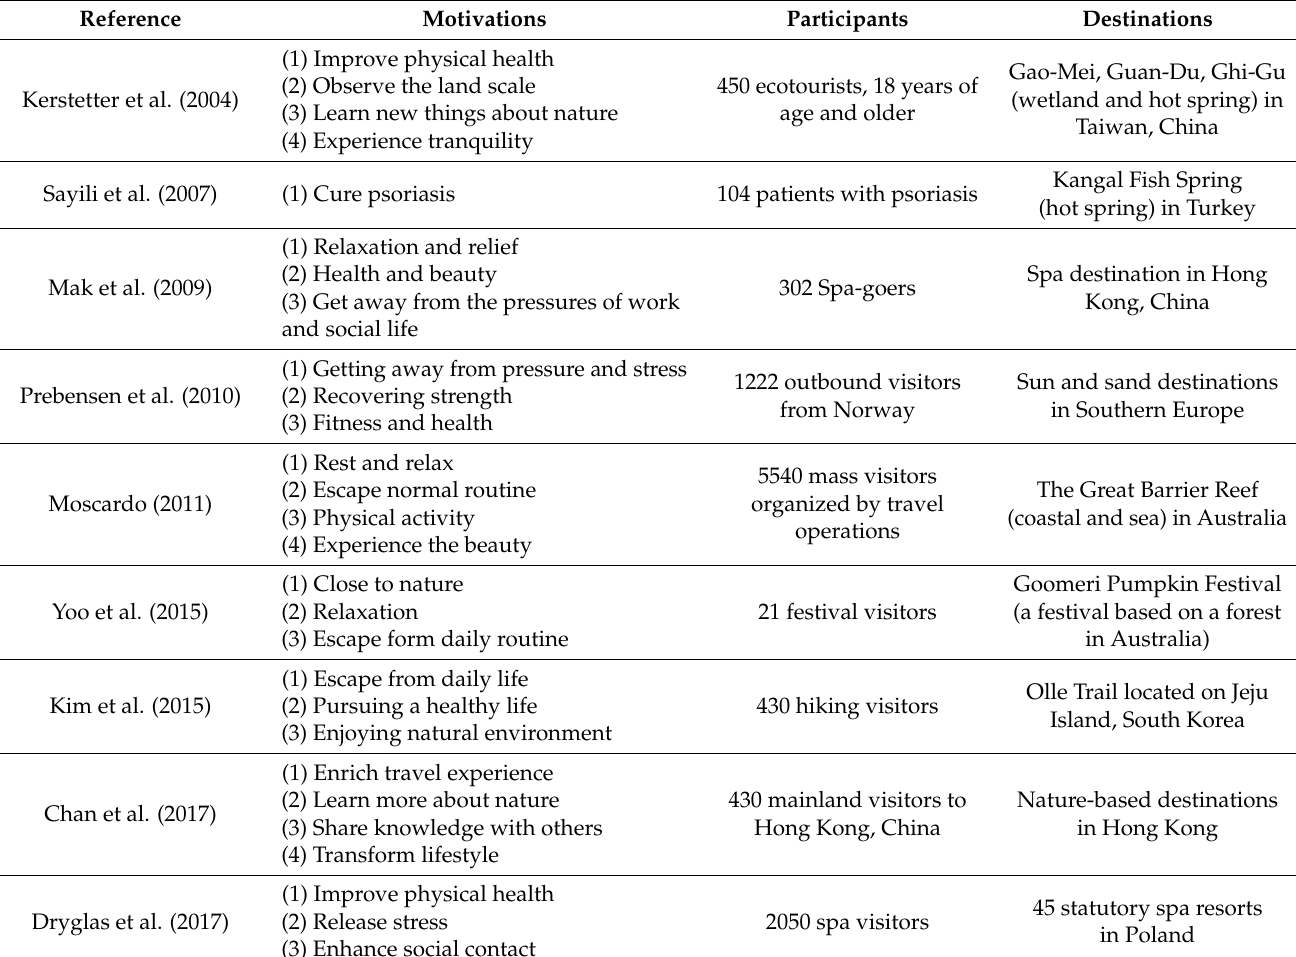
Table 3. Motivations of restorative